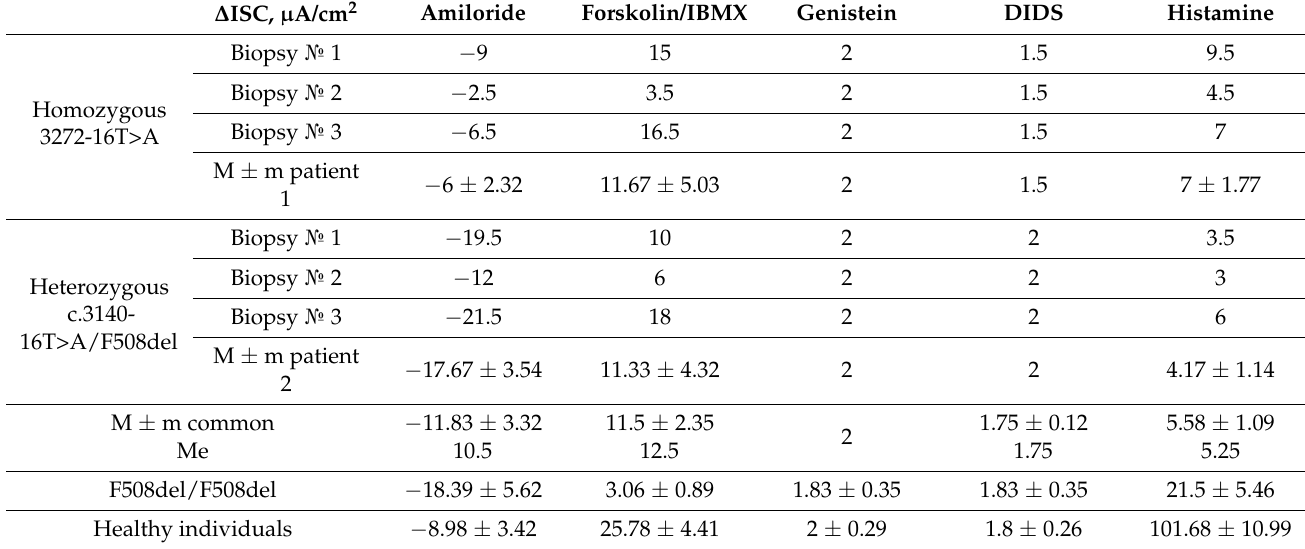
Table 6. Indicators of the short-circuit current density ( ∆ ISC) during the administration of stimulants to patients carrying the genetic variant c.3140-16T>A. ∆ ISC, µ A/cm